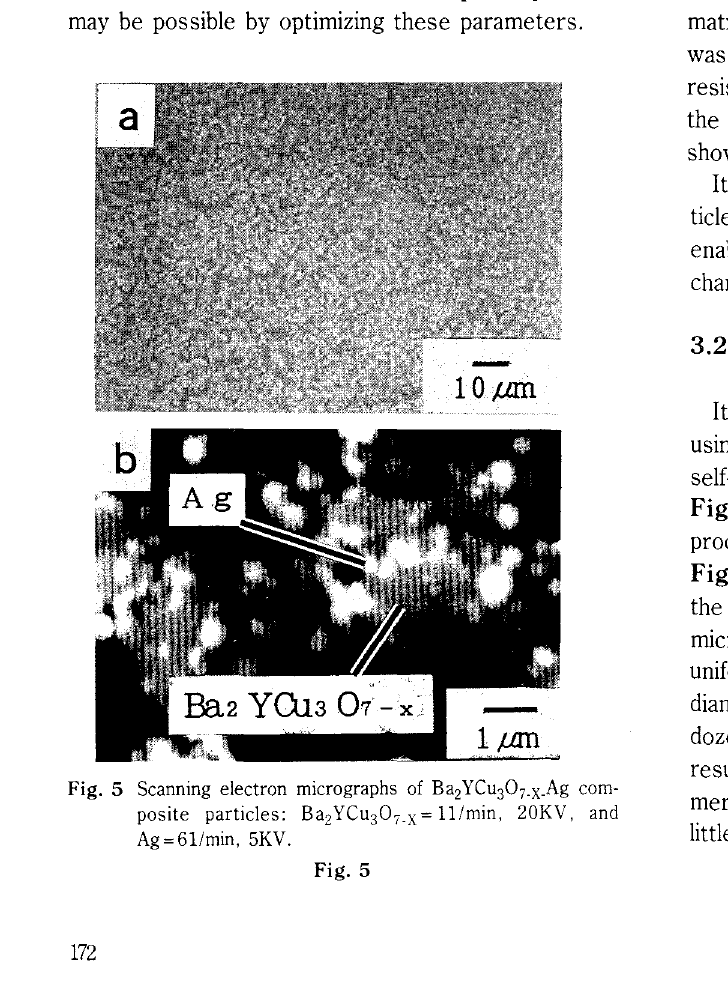
Fig. 5 Scanning electron micrographs of Ba 2 YCu 3 0 7 _x_Ag com posite particles: